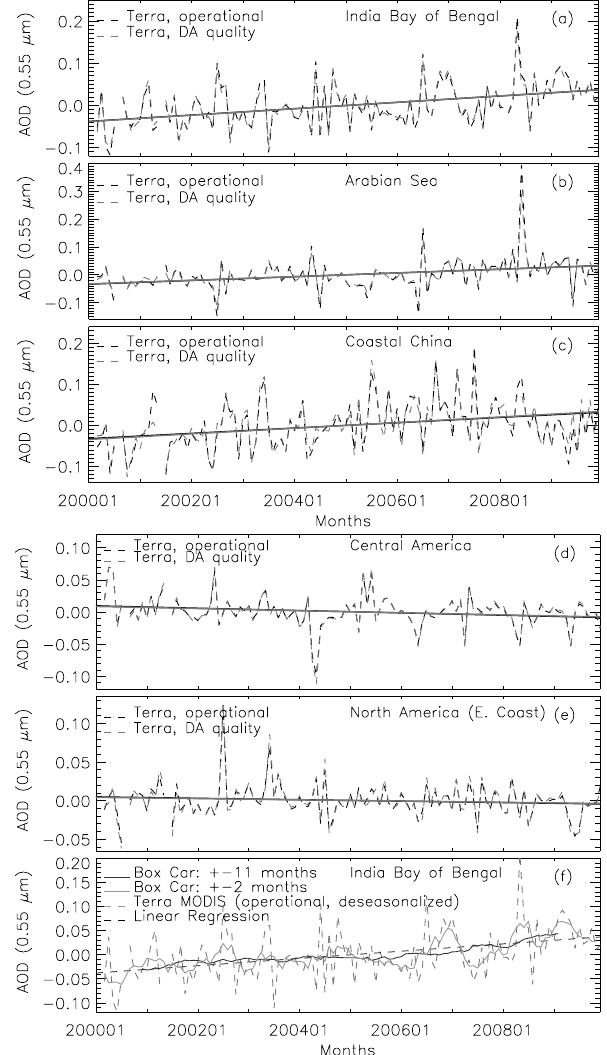
Fig. 8. (a) Similar to Fig. 2b, but for the ten-year AOD trend anal- ysis over the Indian Bay of Bengal region. The | ω / σ ω | of 5.45 is found for the trend, indicates the trend is real with a confident level of 95%. (b–e) Similar to (a) but for the Arabian Sea, Coastal China, Central America, and North America (E Coast) regions